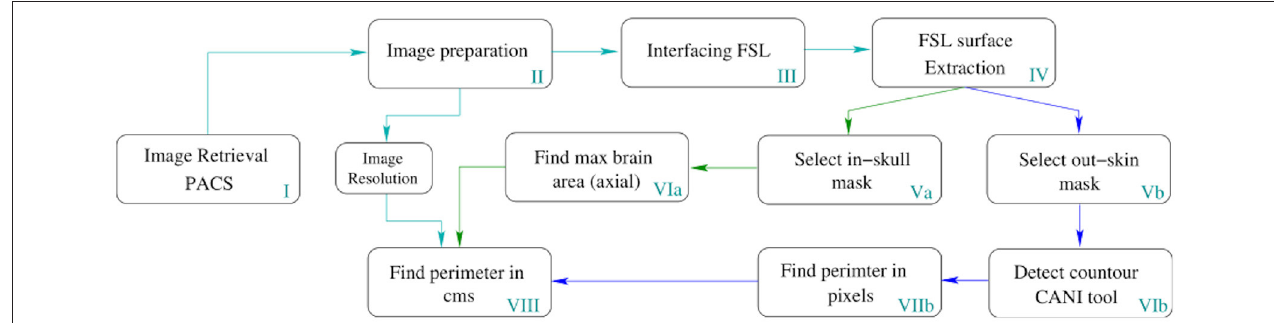
FIGURE 3 | Pipeline for the automatic MHC extraction. The depicted process runs in all slices of the volume but only returns the MHC to place it in the Nellhaus charts. However, this method can measure the perimeter of all the slices comprising the head, enabling the analysis of the whole skull shape to create other indexes.